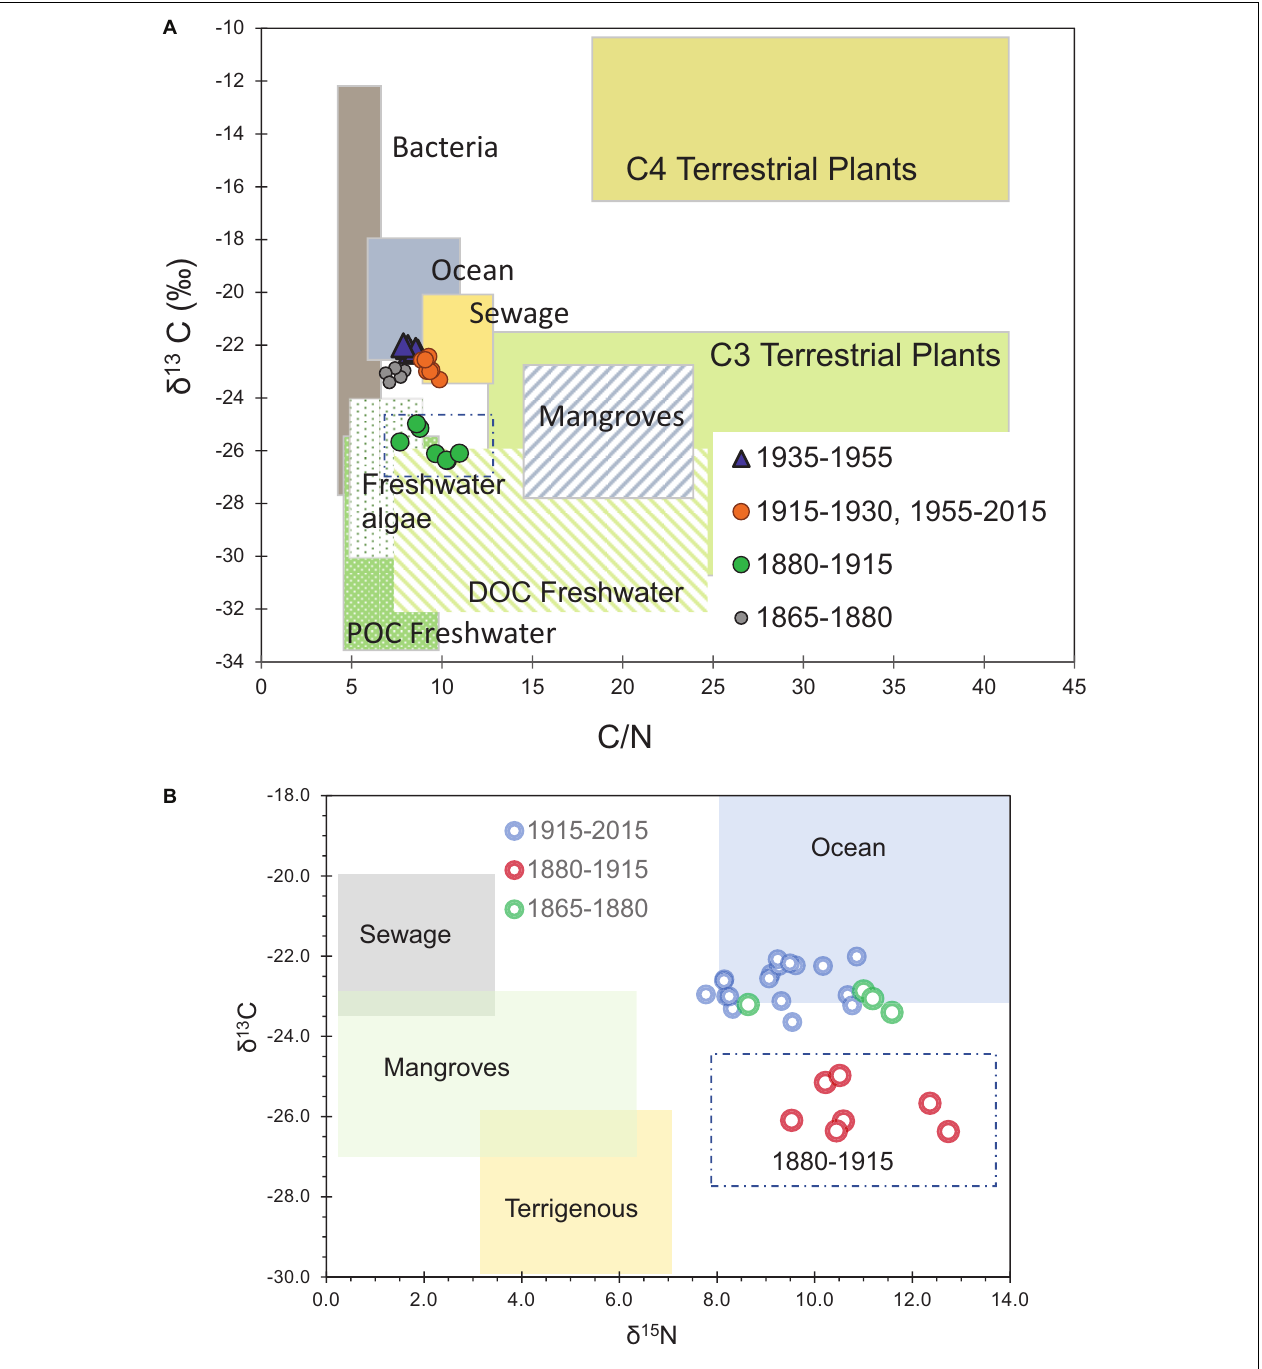
FIGURE 9 | Graph of the values of: (A) δ 13 C against C/N ratio and (B) δ 13 C against δ 15 N. The suggested fields are based on Deines (1980), Lamb et al. (2006), Martinelli et al. (2009), Barros et al. (2010), and Bueno et al. (2019). Points are levels analyzed in the SP5 core. DOC, dissolved organic carbon; POC, particulate organic carbon. The values for the period registered in the SP5 core between 1880 and 1915 were marked in blue dashed lines.